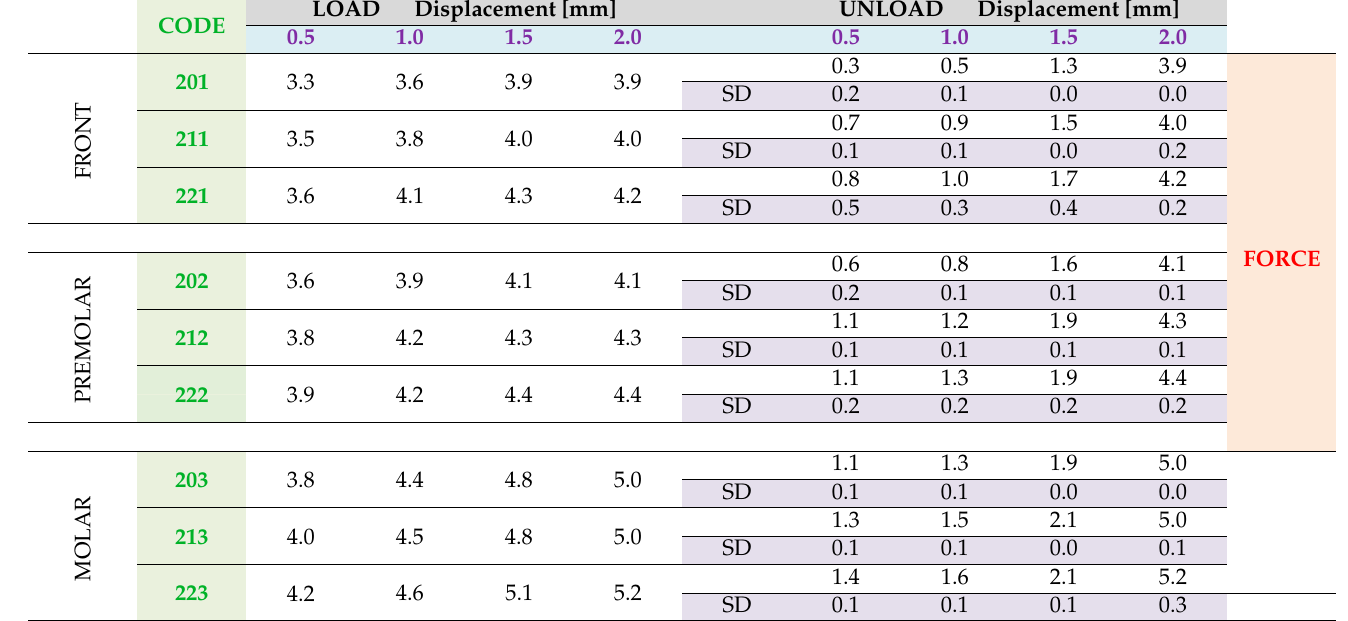
Table 1. Summarized average values of the released forces of Bio-Active ®